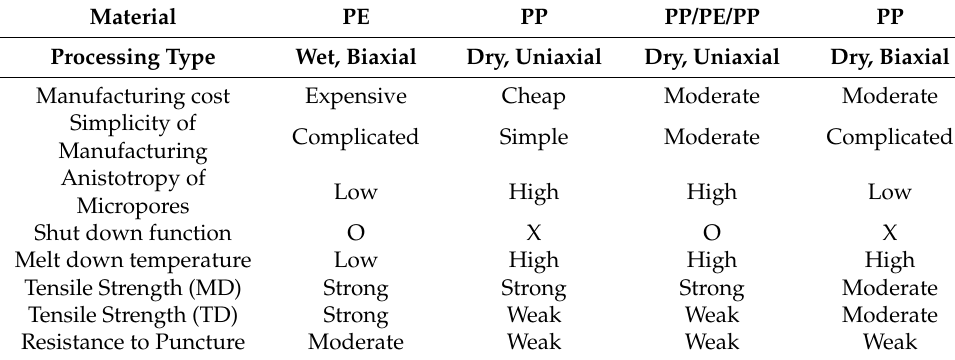
Table 1. Properties of microporous polyolefin separators by processing